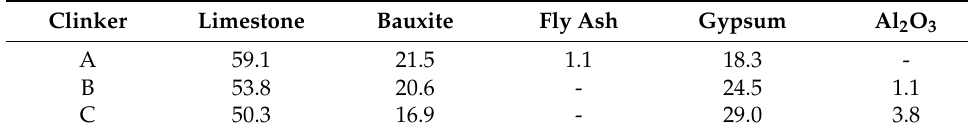
Table 3. Proportions of the raw materials